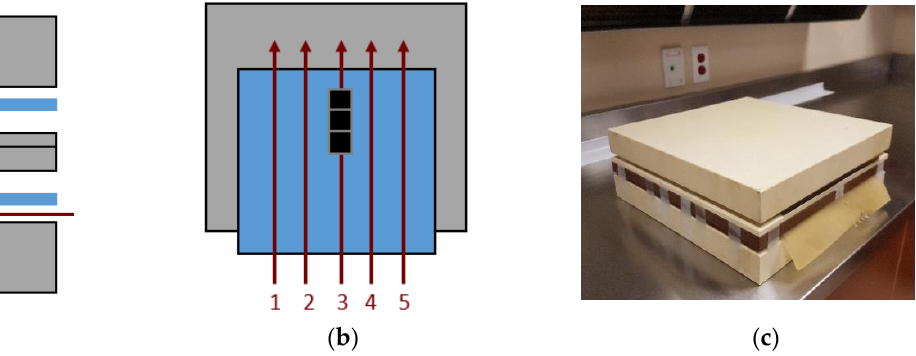
Figure 3. Calibration set up. ( a ) A schematic interpretation of the calibration phantom in sagittal view. The slabs of solid water are represented by the grey blocks, and the superflab bolus is represented by the blue blocks. The OSLDs are represented by the black figures, and the catheters are the red arrows; ( b ) A top view schematic interpretation of the calibration phantom indicating the positions of catheters one to five. Three OSLDs are arranged, one on top of the other, in a superior, middle, and inferior position as shown in the image; ( c ) An image of the calibration phantom fully assembled.